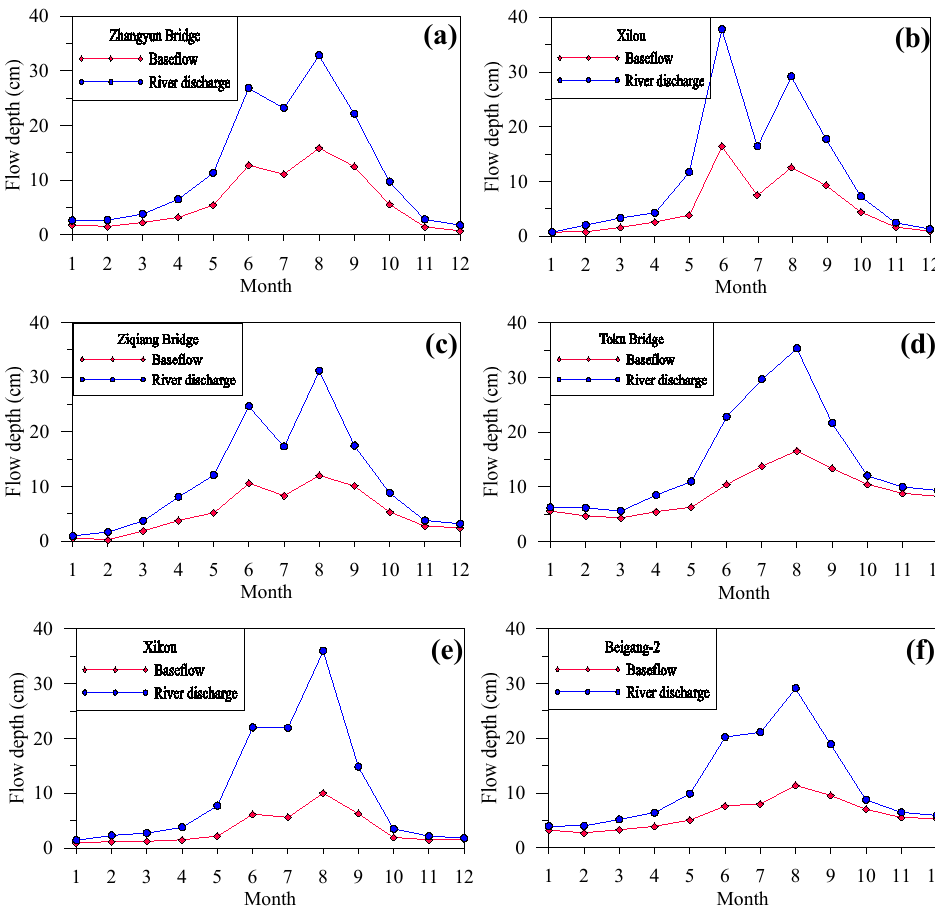
Figure 6. Results of baseflow separation for ( a ) Zhangyun Bridge, ( b ) Xiluo, ( c ) Ziqiang Bridge, ( d ) Tuku Bridge, ( e ) Xikou, and ( f ) Beigang-2 in the Choushui River alluvial fan. Table 3. Assessment results of baseflow index and recharge rate in the Choushui River alluvial fan.